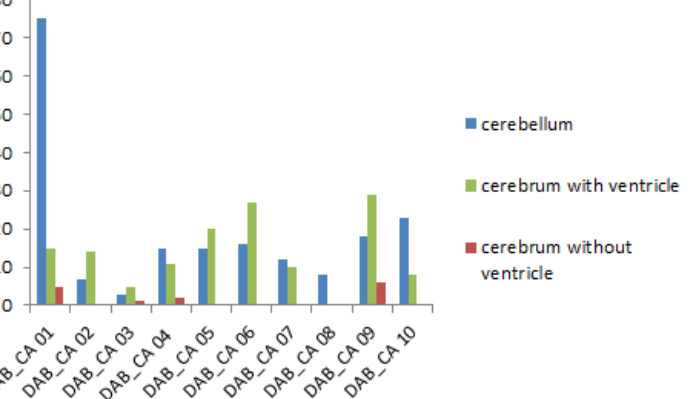
Figure 5. Parrot bornavirus (PaBV) antigen distribution in the brain of trial B group 2 (PaBV-4 inoculation in the chorioallantoic membrane). The y -axis shows the number of PaBV antigen-positive cells counted in one slide (200 × total magnification). The PaBV antigen distribution similar to trial B group 1. The x -axis shows each individual embryo ( n = 10, laboratory number). In group 3, there were significantly more PaBV antigen-positive cells in the cerebellum than the cerebrum without ventricles (U = 1, p = 0.02144). There was not a significant difference in the PaBV antigen distribution between the cerebellum and the cerebrum with ventricles (U = 7, p = 0.29834). Moreover, there was not a significant difference between the cerebrum with and without ventricles (U = 5.5, p = 0.17384) (Figure